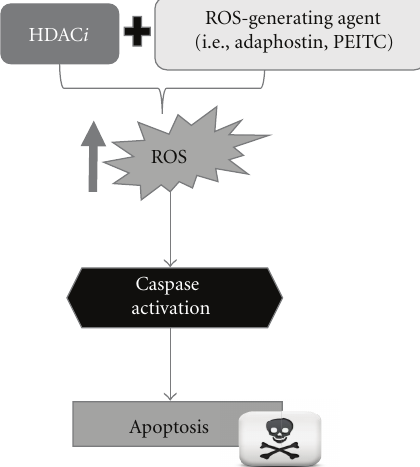
Figure 2: Activation of apoptosis by combinations of HDACi and ROS-generating agents. HDACi combined with agents like adaphostin and PEITC result in an increase production of ROS in cancer cells. The high levels of ROS result in induction of apoptosis via caspase